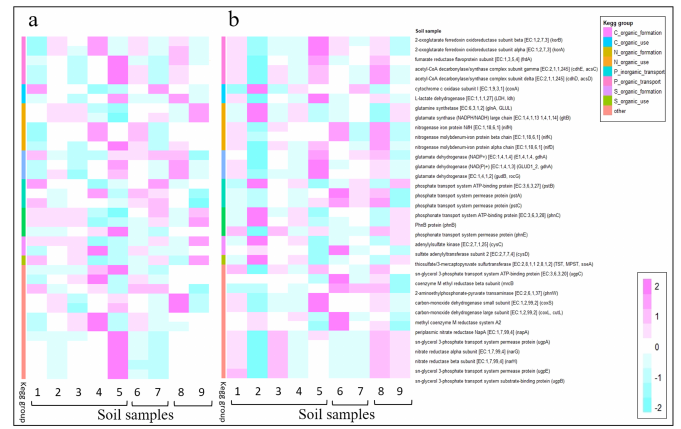
Figure A2. Functional prediction of bacterial populations in different season. Summer ( a ) and winter ( b